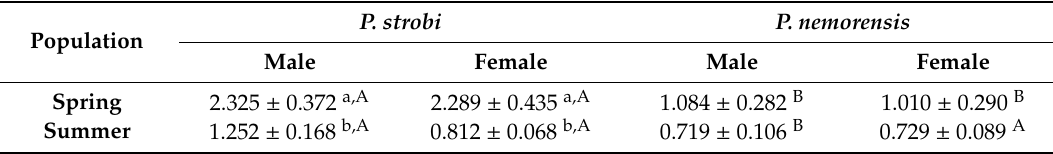
Table 1. The average amounts of CHCs per weevil ( µ g) of both sexes from the spring and summer populations of P. strobi and P. nemorensis † , ‡